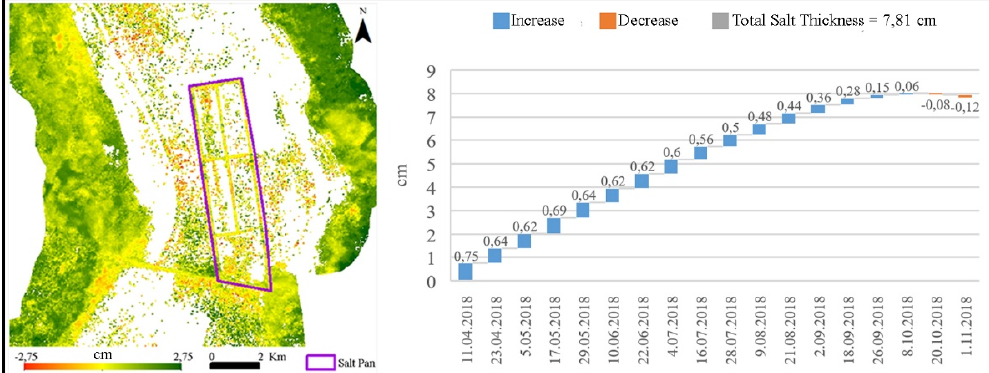
Figure 14. Salt movements obtained by SBAS results. The location of the salt pan is shown on the LOS direction SBAS map in the left image, while the change in the salt height in this salt pan is graphically displayed on the right (Calculations were made by converting to vertical units).4. Con-